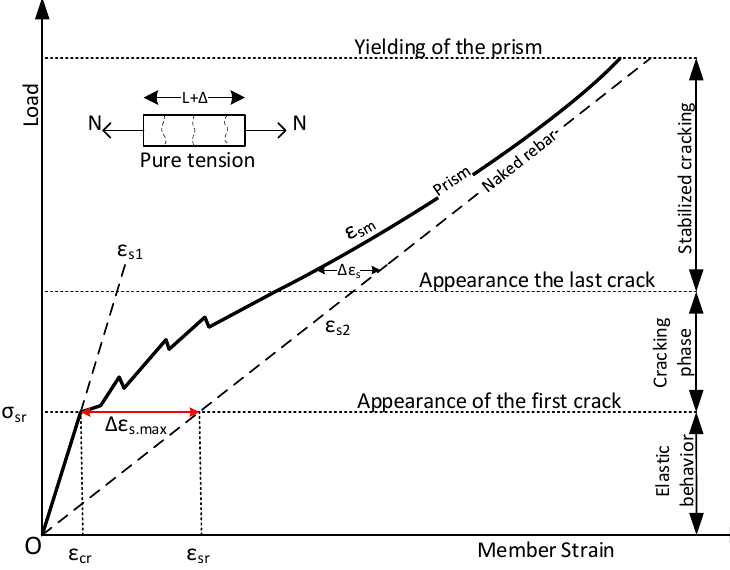
Figure 2. Conceptual model of tensile behavior, including identification of the most relevant stages. Discussed by ref. [10] in detail.